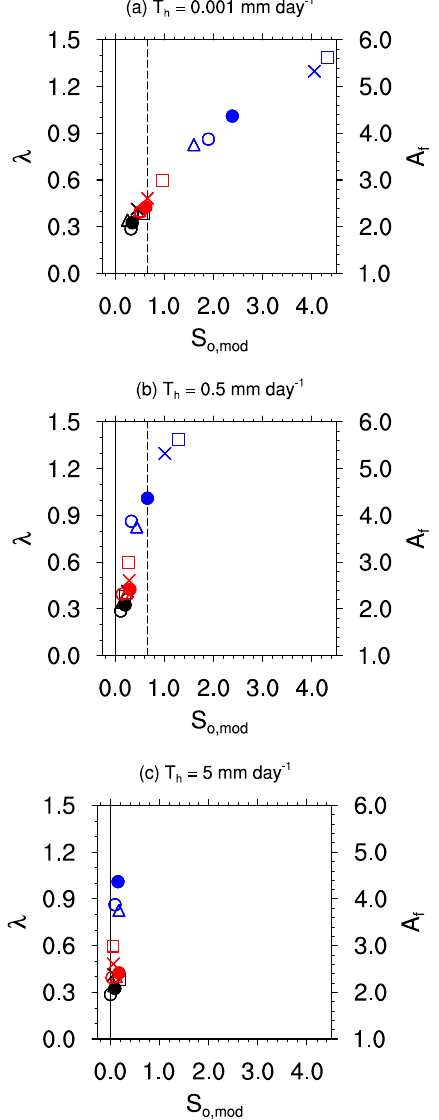
Figure 5. As in Fig. 3 except for λ vs. S o, mod , i.e., where the de- nominators of the x and y axes are the same. The vertical dashed lines in (a) and (b) correspond to the surface remotely measured value of S o, mod , i.e., 0.66 (Mann et al., 2014), which was based on rain rates ranging from approximately 0.002 to 0.5mmday − 1